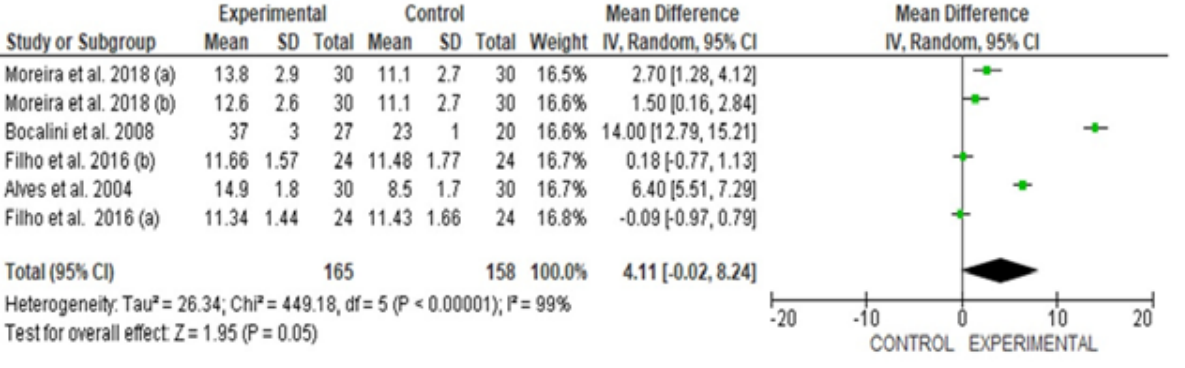
Figure 2. Forest plot of the six results of the four studies selected for leg strength and endurance measured by the “ Sit and stand up” (repetitions) test in the Rikli Jones test